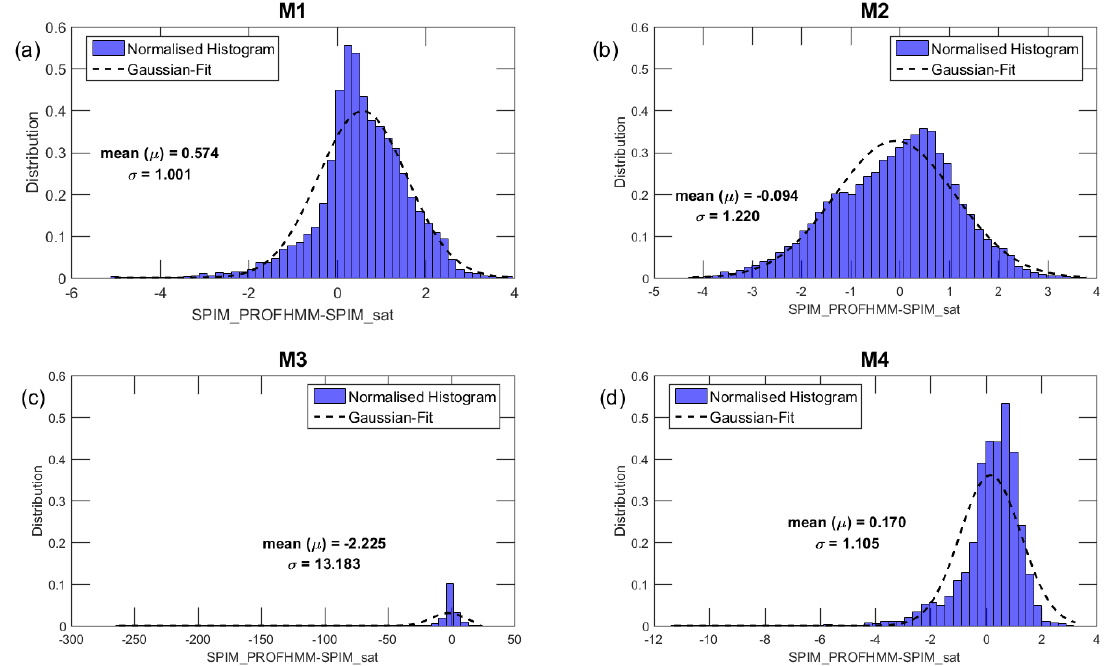
Figure 9. The error distribution of suspended particulate inorganic matter (SPIM) between PROFHMM and satellite SPIM along with the Gaussian fit for ( a ) M1, ( b ) M2, ( c ) M3, and ( d ) M4 stations. The mean and standard deviations of the error derived for each station show mean values near to zero, except at the station M3 (Table 2). The standard deviation of the error for M1 is ( ± 1.00), for M2 is ( ± 1.22), for M3 is ( ± 13.18) and for M4 is ( ± 1.11). Because of the small number of but large outliers in